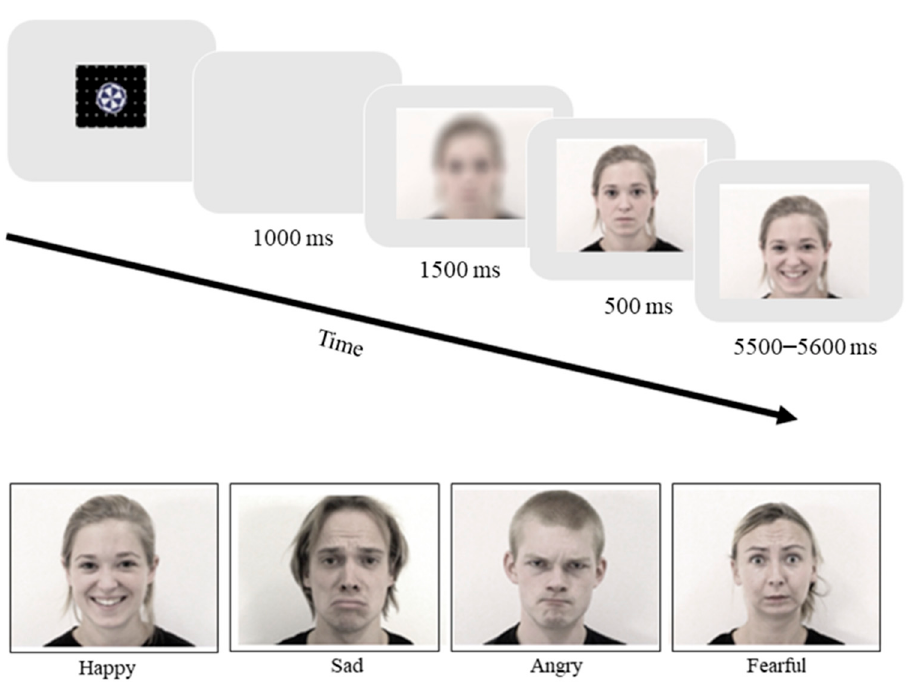
Figure 2. Time flow of the trials and examples of the emotional stimuli.